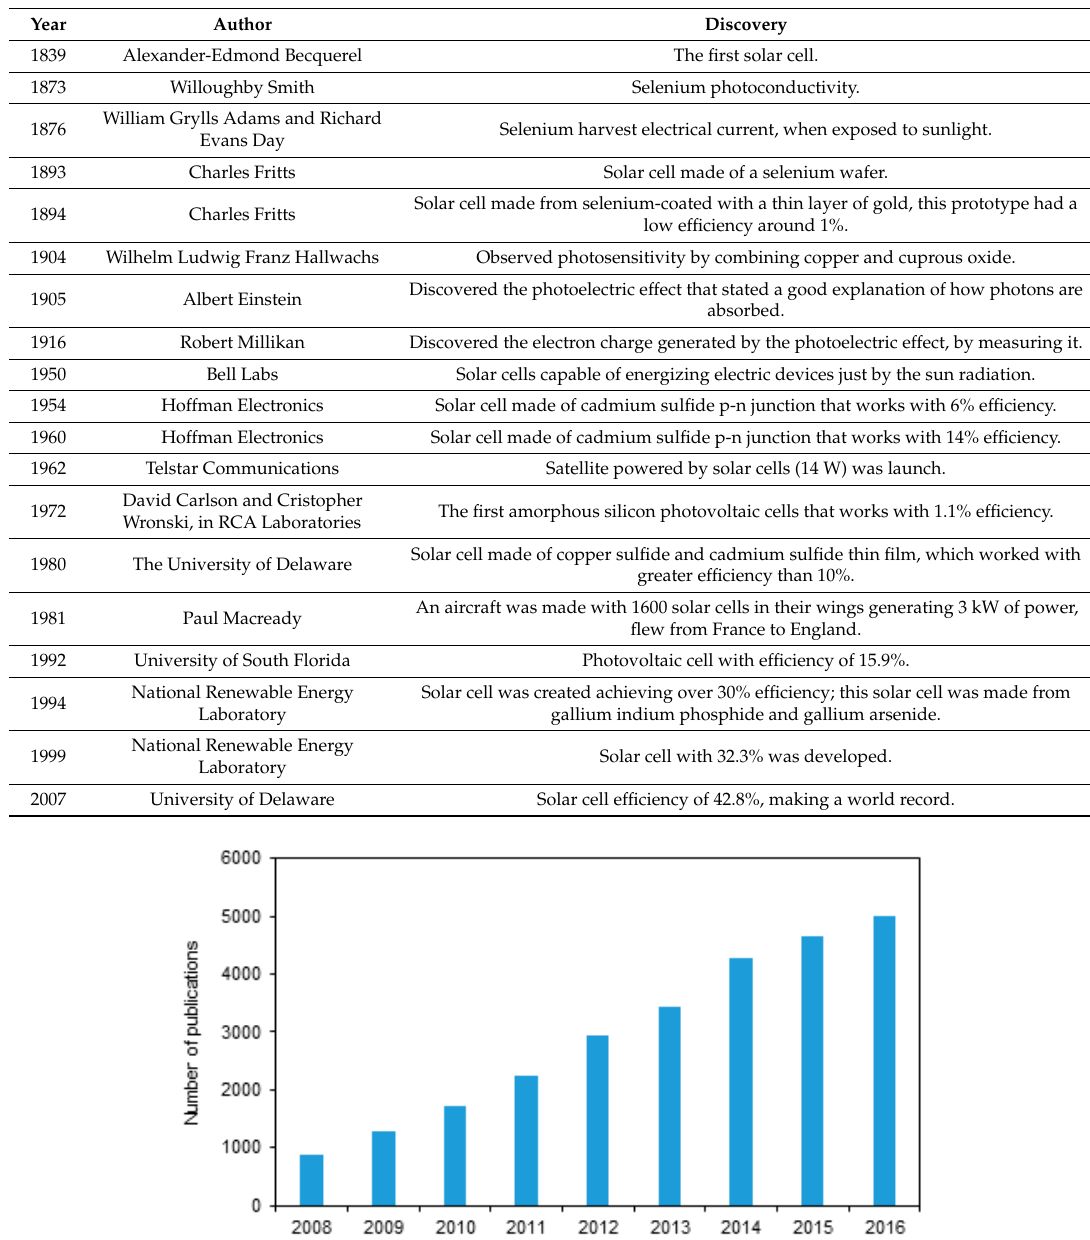
Table 1. Advances and discoveries associated with solar cells over the decades.